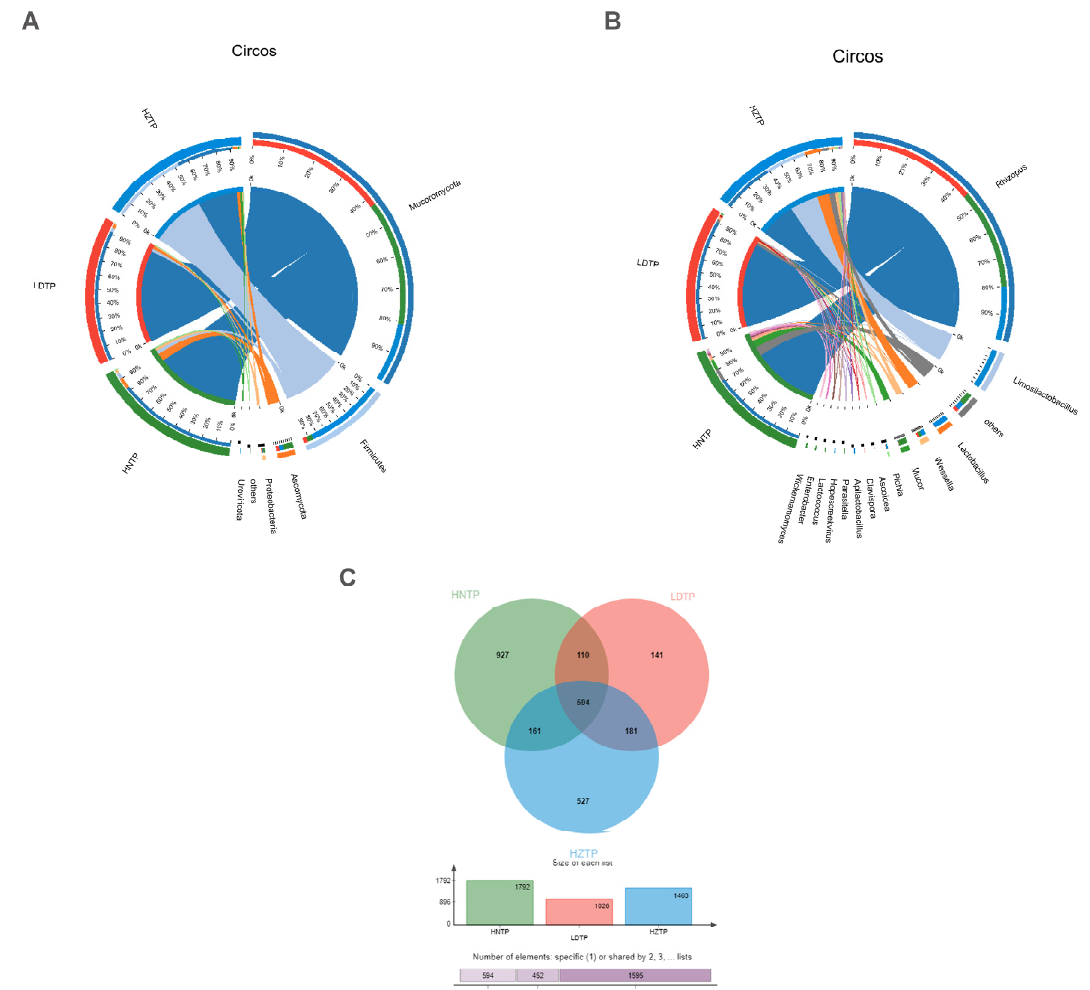
Figure 1. The Circos microbial composition of Tianpei samples with NR annotation. ( A ) At the phylum level and ( B ) at the genus level. ( C ) A Venn diagram illustrating shared and unique species among three Tianpei